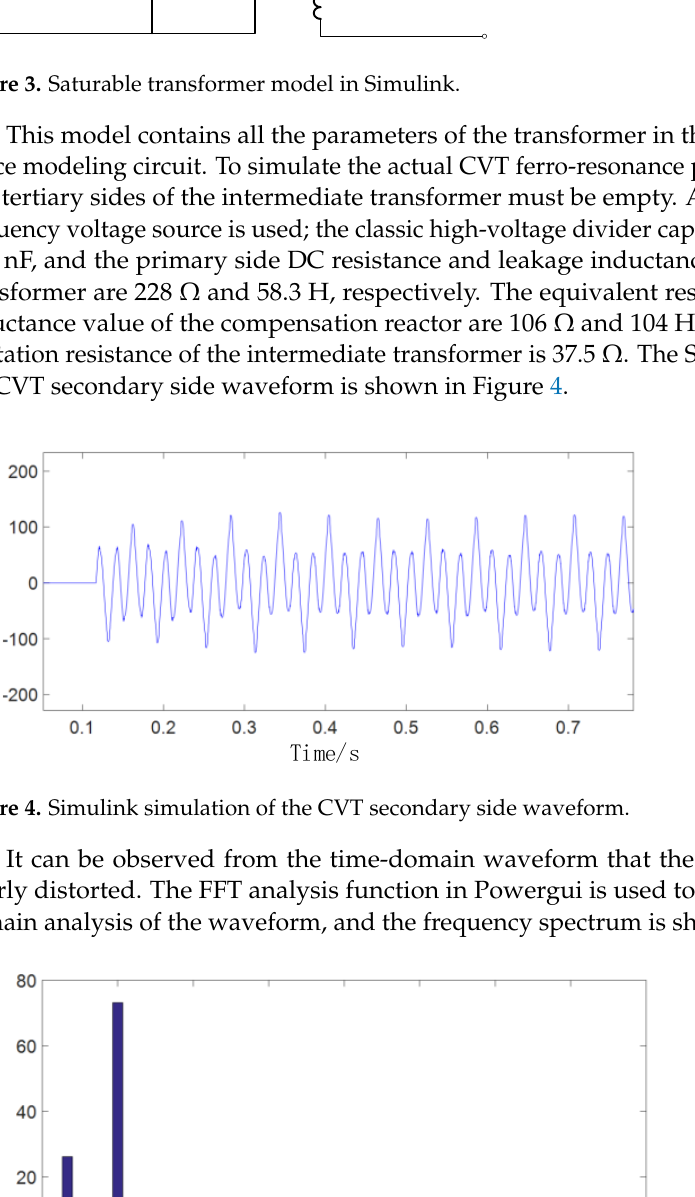
Figure 3. Saturable transformer model in Simulink.